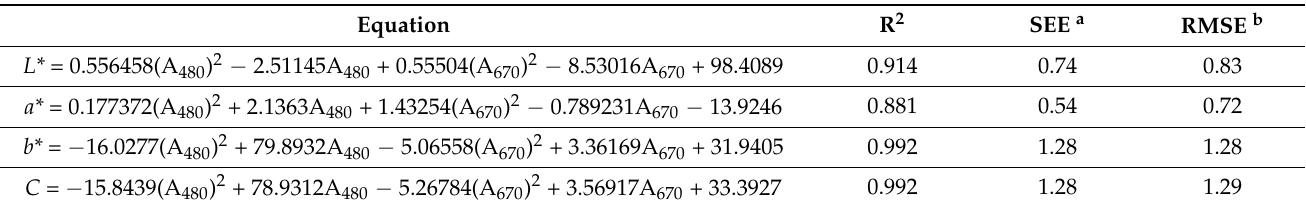
Figure 7. Block diagram of the proposed spectrophotometer. Table 11. Equations for estimating the chromatic coordinates and the chroma C of olive oil, measuring the absorbance at only 480 nm and 670 nm [76].